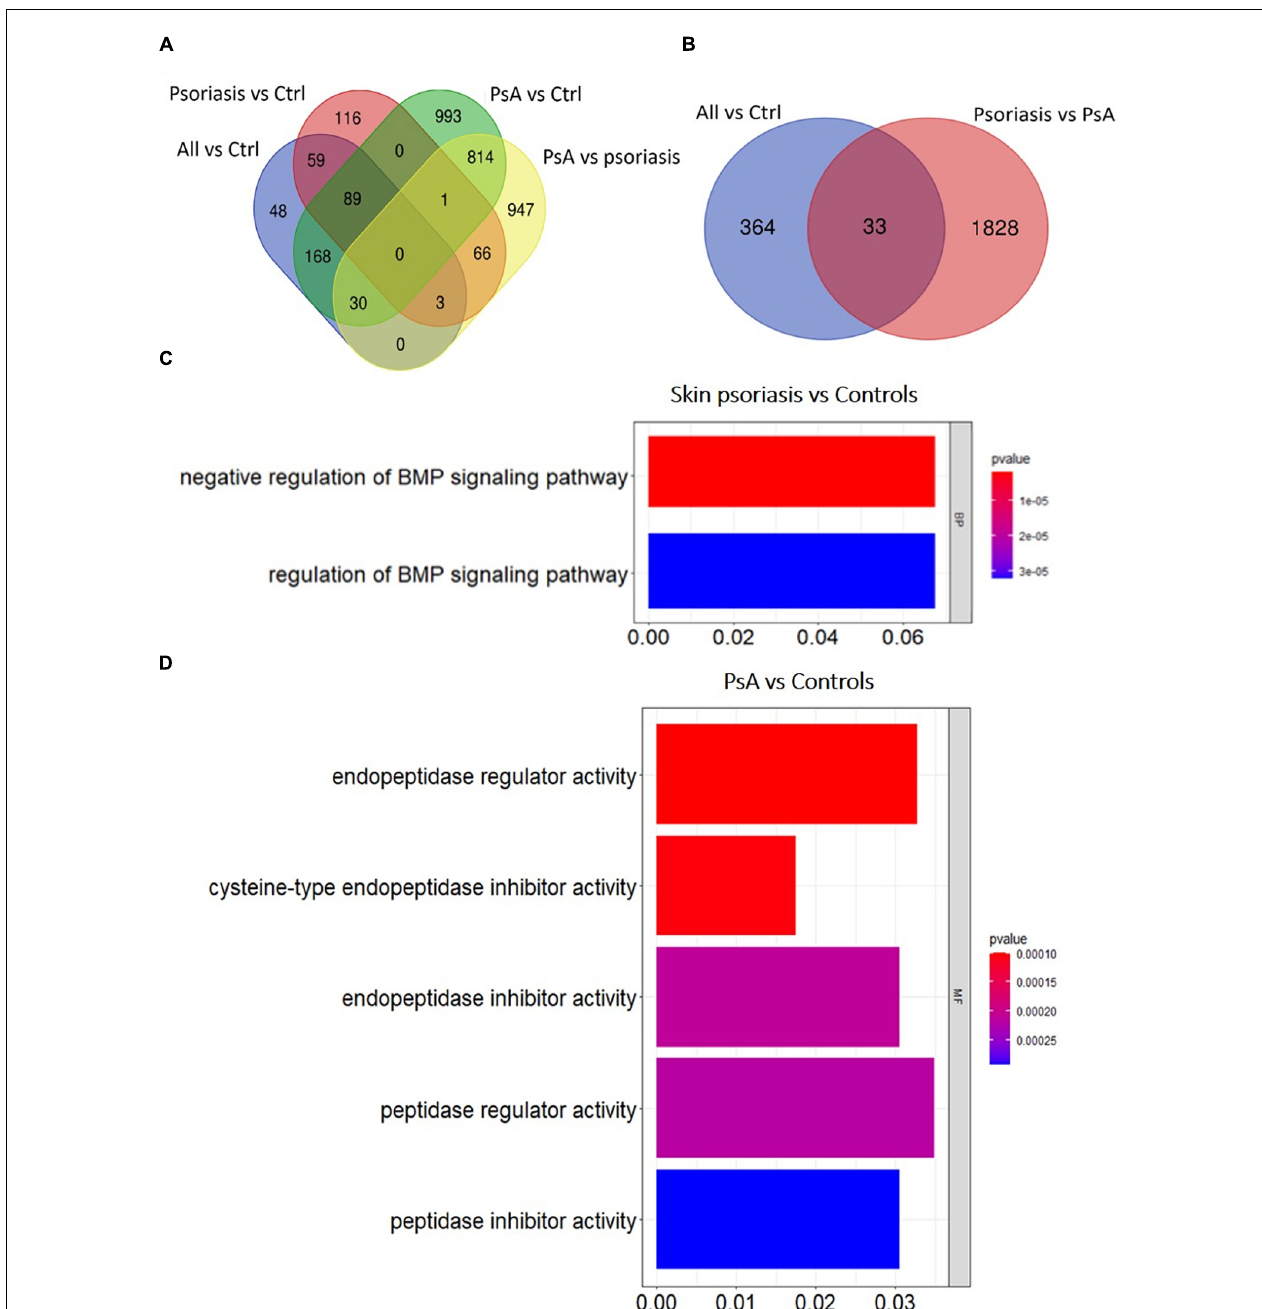
FIGURE 3 | Shared and unique methylation patterns in CD8 + T cells from psoriasis patients and controls, and pathways affected. (A) Venn diagram showing overlapping and differentially methylated positions (DMP) found in psoriasis patients versus controls (Ctrl). Differences were tested between “All” (skin psoriasis and psoriatic arthritis combined) and Ctrl (healthy control), controls versus skin psoriasis patients, controls versus psoriatic arthritis (PsA) patients, and skin psoriasis versus PsA patients (A) . (B) Contrasts were assessed only between “All” and Ctrl and skin psoriasis versus PsA patients. (C,D) The bar plots show the results of the Gene Ontology (GO) analysis of genes which presented at least on DMP in their promoter. Only significantly enriched terms for Biological Process (BP), Cellular Component (CC) and Molecular Function (MF) are represented ( P < 0.05), in “skin psoriasis” versus Controls (C) and PsA versus Controls (D) .